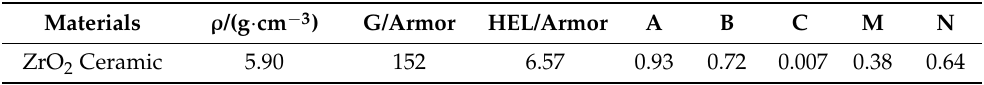
Table 1. Parameters of the ZrO2 ceramic material.